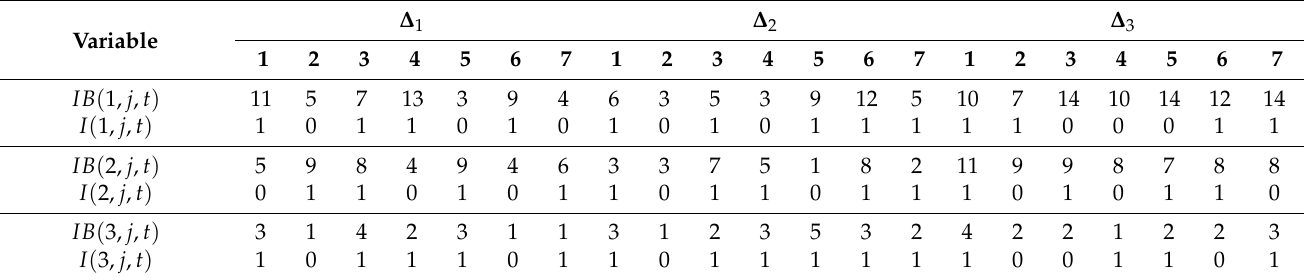
Table 5. Influencing factor scores, utilities, and possibilities.